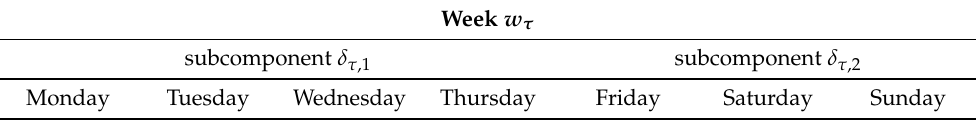
Table 1. Component segmentation into